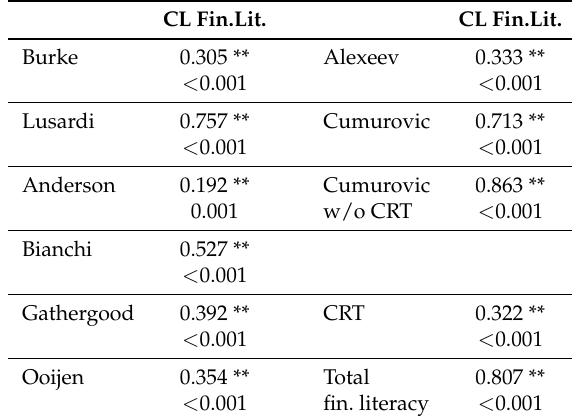
Table 7. Correlations of the Cumurovic-Lusardi scale (CL) with the existing scales, with CRT, as well as with the total financial literacy score. The correlation with the total financial literacy score is high at 80.7% and is indicative of the high potential of the new scale.